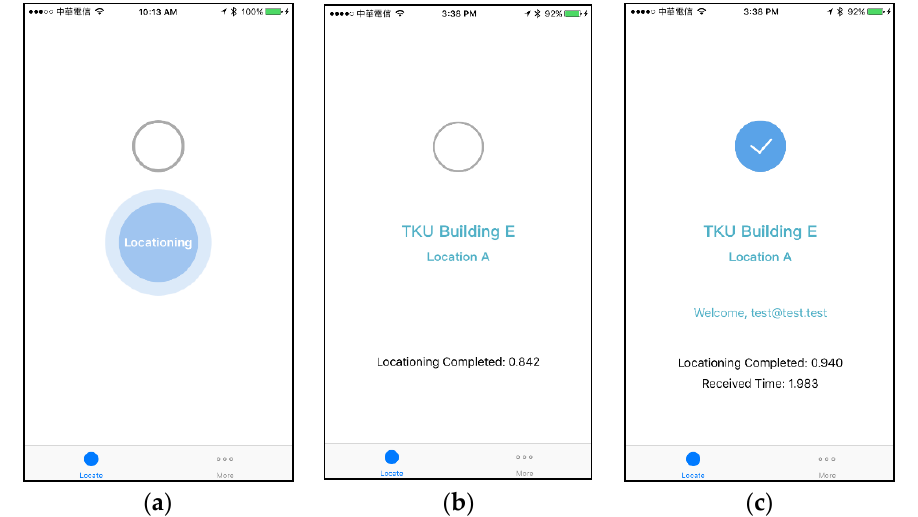
Figure 8. Screenshots of our Mobile App ( a ) during the locating process ( b ) physical location determined ( c ) acknowledgement message received.